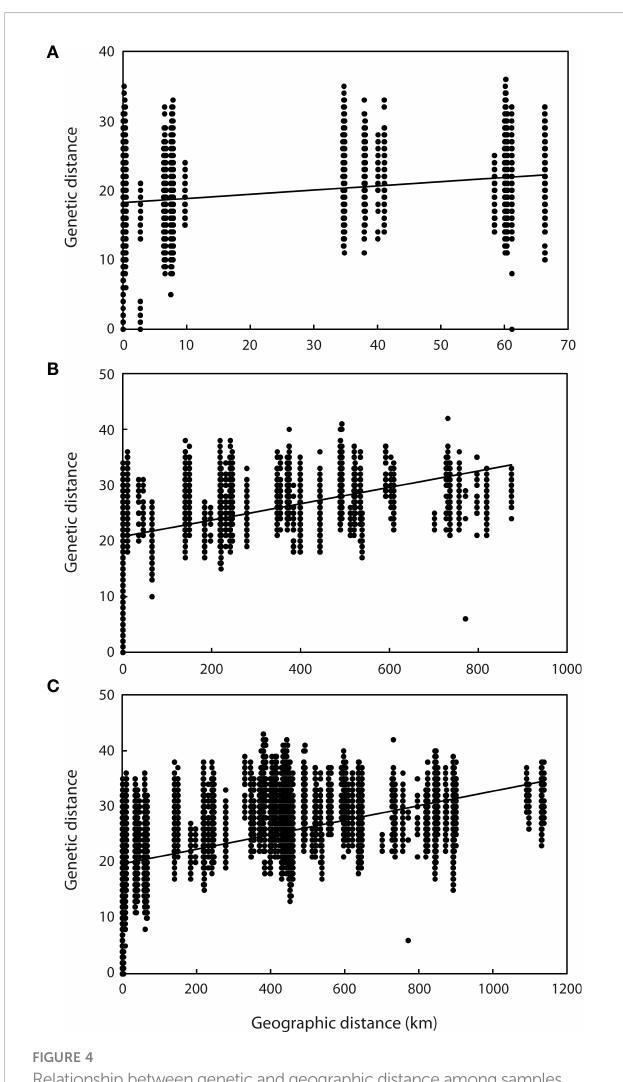
FIGURE 4 Relationshipbetweengeneticandgeographicdistanceamongsamples. (A) Relationshipbetweenall samplesfromthe nine HainanIsland populations( y =0.0603 x +18.209, r =0.351, p < 0.001). (B) Relationship betweenall samplesfromthe 11mainlandIndochinesepopulations ( y =0.0147 x +20.751, r =0.465, p< 0.001). (C) Relationshipbetweenall samplesfromall 20populations( y =0.013 x +19.724, r =0.625, p<